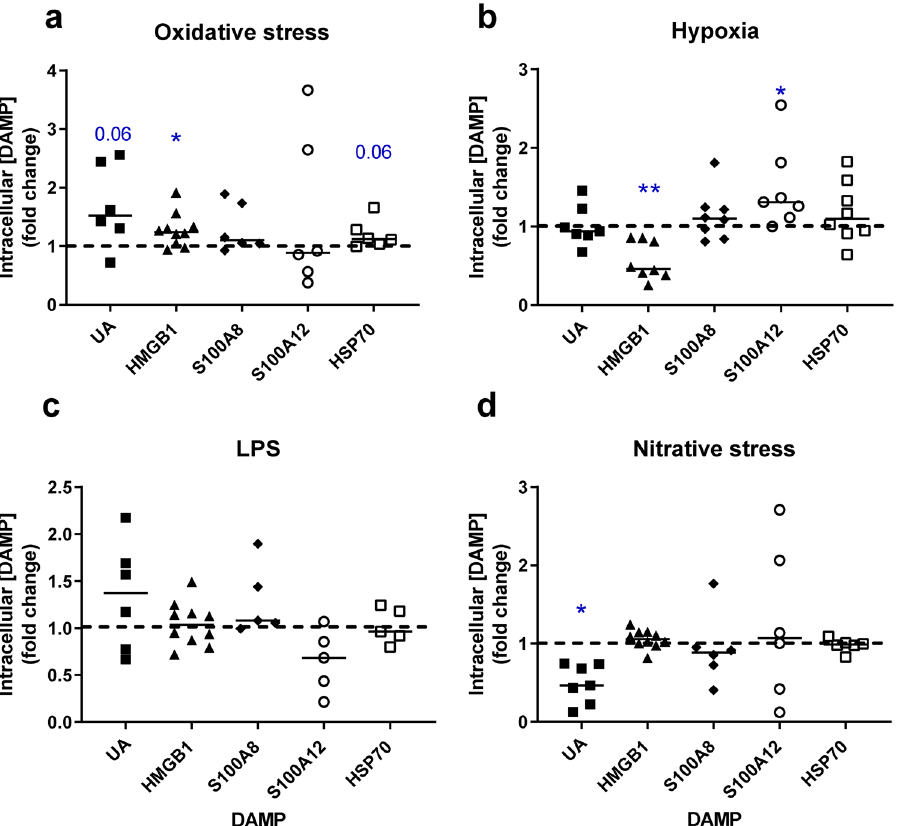
Figure 2. Effect of placental insults on intracellular concentrations of DAMPs in term placental explants. Explants were exposed for 72h to ( a ) oxidative stress (1 mM H 2 O 2 ), ( b ) hypoxia (1%O 2 ), ( c ) low dose LPS (1 ng/ ml to mimic subclinical infection), ( d ) nitrative stress (1 mM SIN-1). Concentrations of uric acid (UA), high mobility group box 1 (HMGB1), S100 calcium binding proteins A8 (S100A8) and A12 (S100A12), heat shock protein 70 (HSP70) were measured in placental lysates and corrected for explant protein content. Data are fold change from control conditions (n = 5–10, line represents median); dashed line represents control values. * p < 0.05, ** p < 0.01 Wilcoxon signed rank